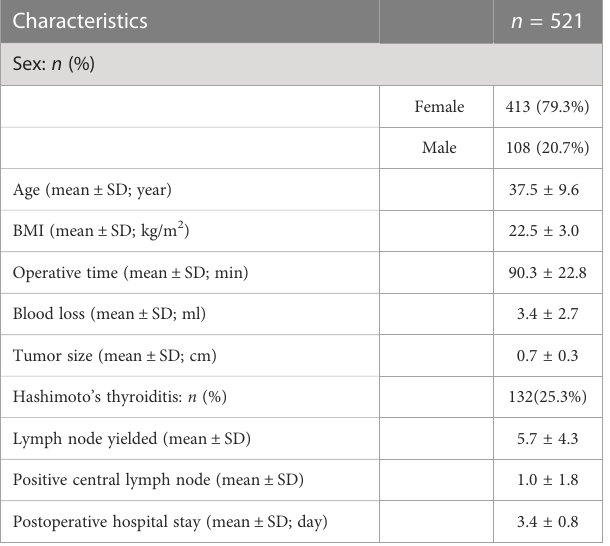
TABLE 1 Baseline characteristics of PTC patients underwent ET via GUA approach with fi ve-settlement method. Characteristics